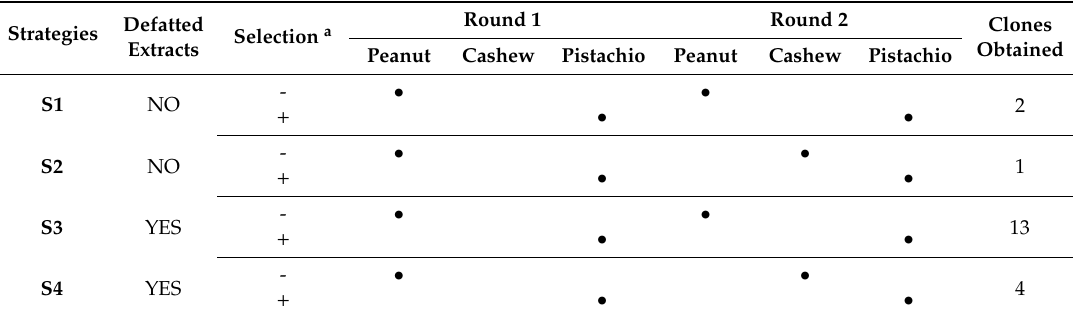
Table 2. Di ff erent biopanning strategies used, and number of specific pistachio-binding clones obtained from each